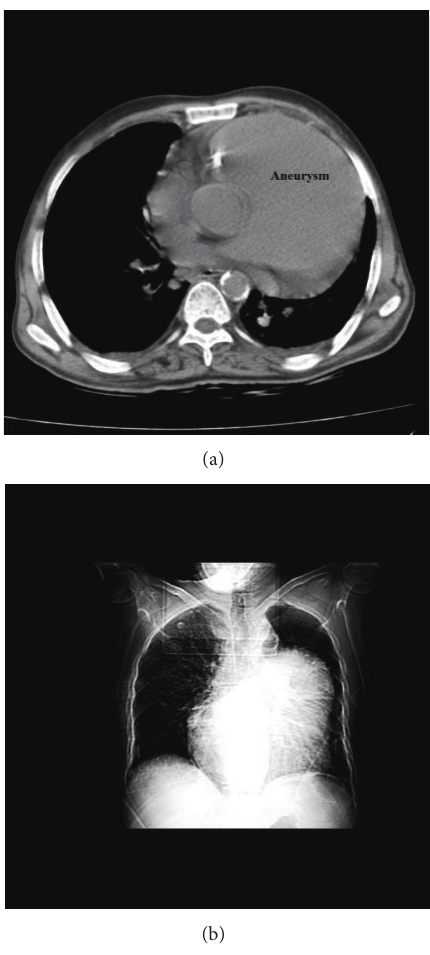
Figure 3: Patient’s computed tomography and chest radiography (b) confirmed